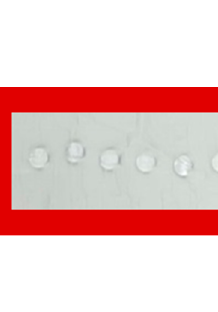
Figure 5. Water droplets (5 μ L) deposited on the TiO 2 - on -PHB mat.